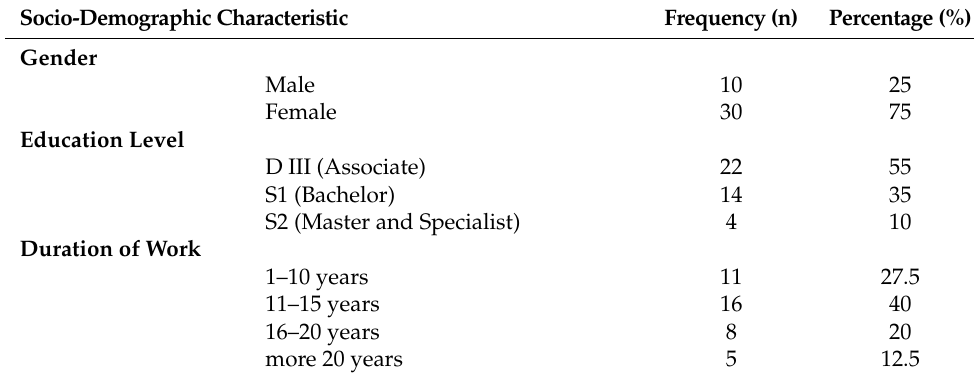
Table 1. Socio-demographic characteristics of the nurses at the Mental Hospital of West Java Province (n =